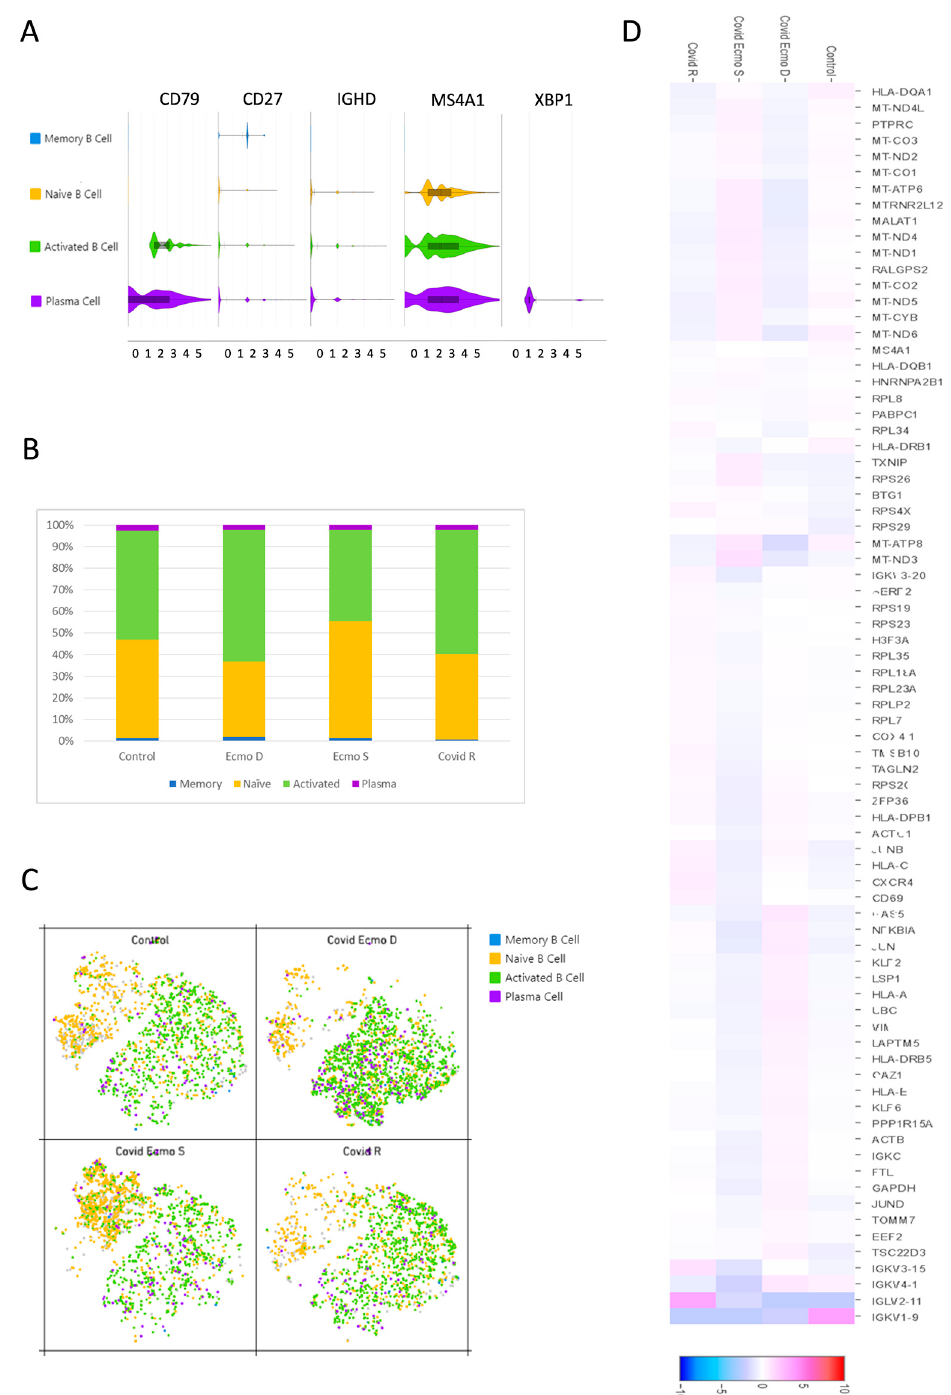
Figure 2. Features of B cell subsets. ( A ) Violin plots show the expression distribution of canonical cell markers in B cell subsets. ( B ) Proportion of B cell clusters in each sample. ( C ) t-SNE projection of B cells from all four samples. Each dot corresponds to a single cell, colored according to cell clusters. ( D ) Heat map representation of differentially expressed genes of B cell populations in the COVID ECMO S, COVID ECMO D, COVID R, and the healthy control. Genes with a maximum adjusted p -value of 0.01 and an absolute value of log2 (fold change) >0.5 were considered to be differentially expressed